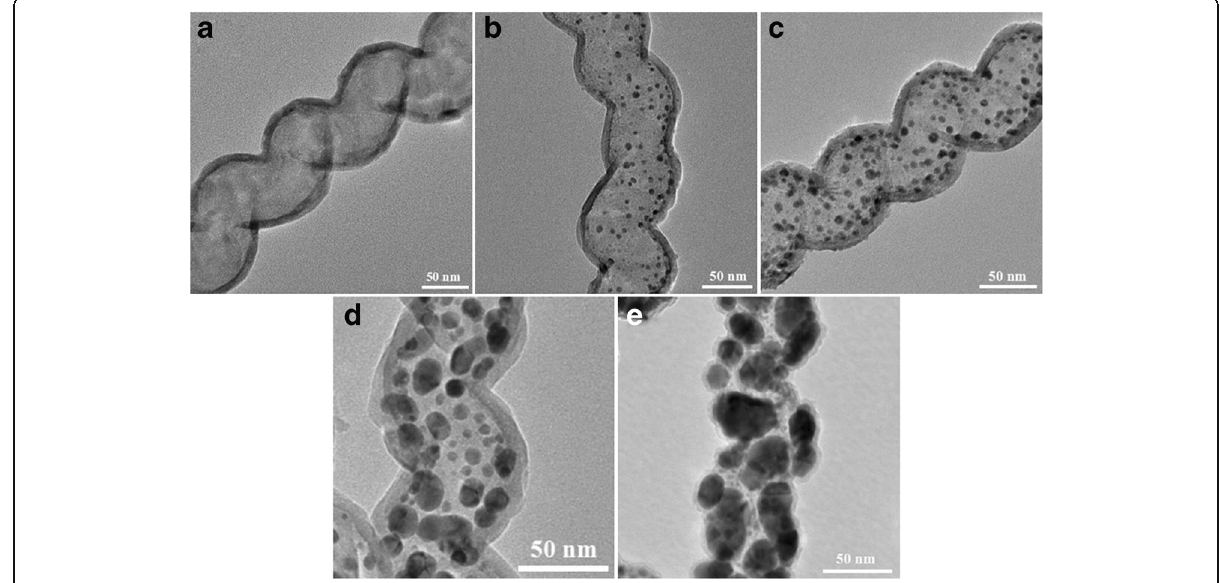
Fig. 3 TEM images. a TiO 2 . b Au-30@TiO 2 . c Au-50@TiO 2 . d Au-80@TiO 2 . e Au-120@TiO